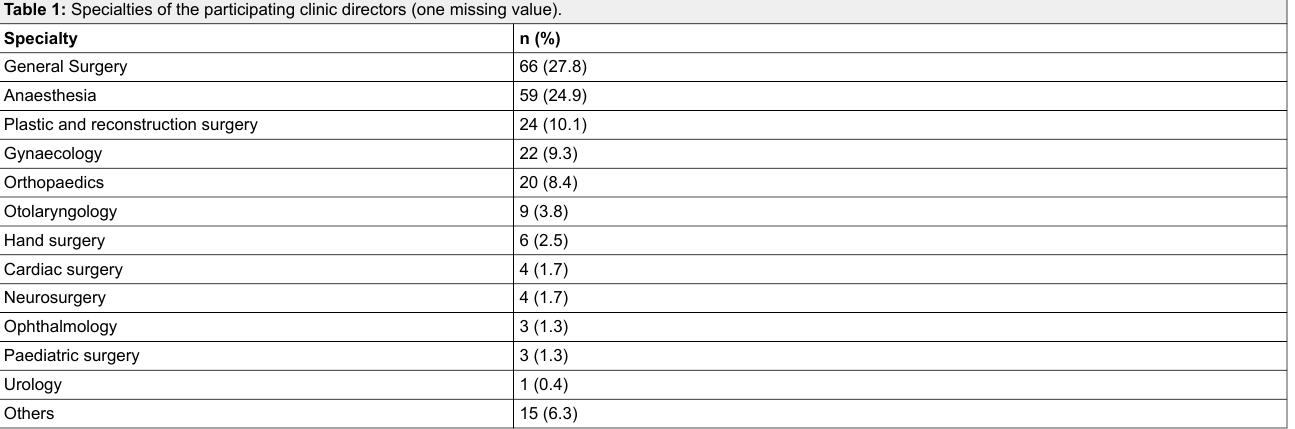
Table 1: Specialties of the participating clinic directors (one missing